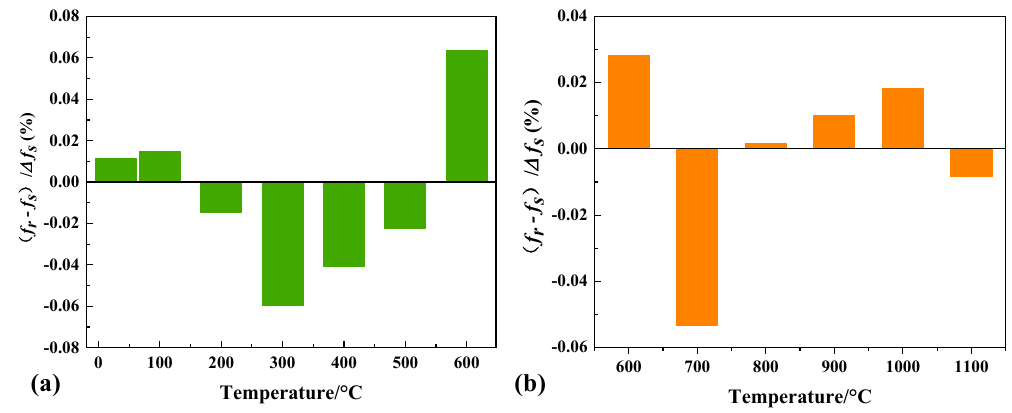
Figure 10. ( a ) Nonlinearity errors in the temperature range of 28 to 600 °C. ( b ) Nonlinearity errors in the temperature range of 600 to 1100 °C.